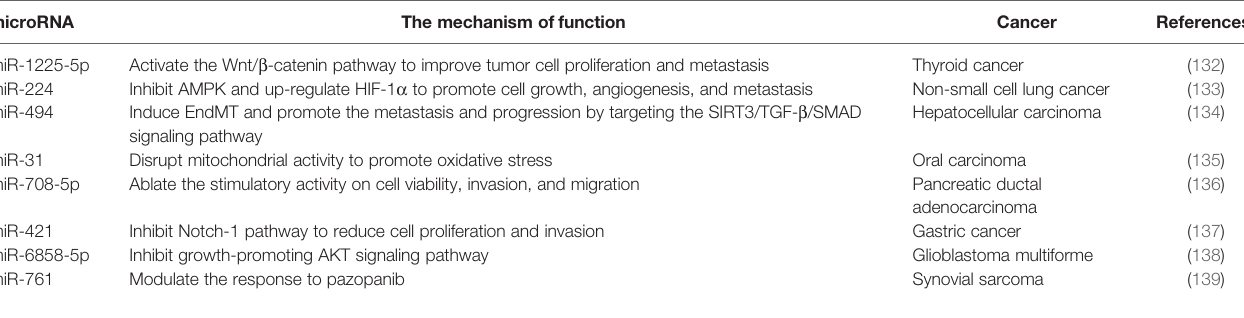
TABLE 5 | The targeting of SIRT3 protein by microRNA in cancer.